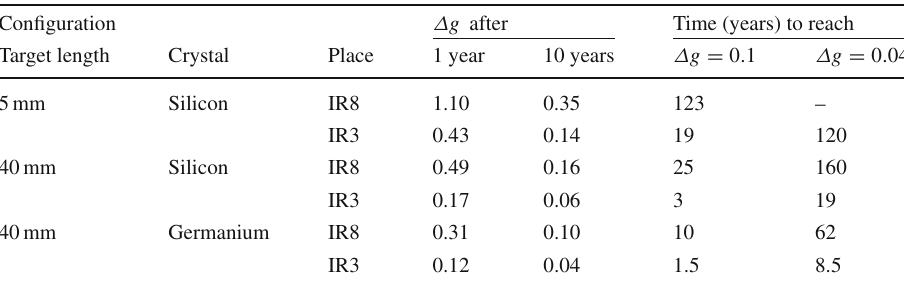
Table 3 Central values of absolute statistical error of g -factor after 1 and 10 years of data taking for various configurations. Data taking time needed to reach Δ g = 0 . 1 and Δ g = 0 . 04 (last two columns)